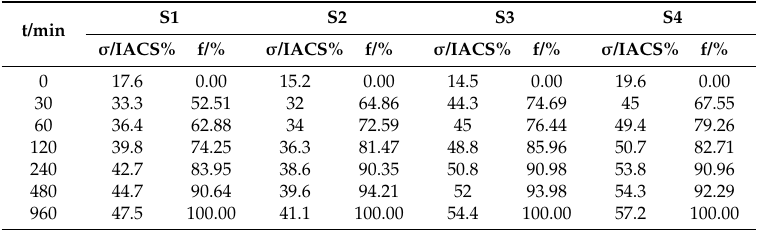
Table 3. The electrical conductivity and new phase volume transformation ratio of precipitate for alloys aged at 500 ◦ C for multiple periods of time.